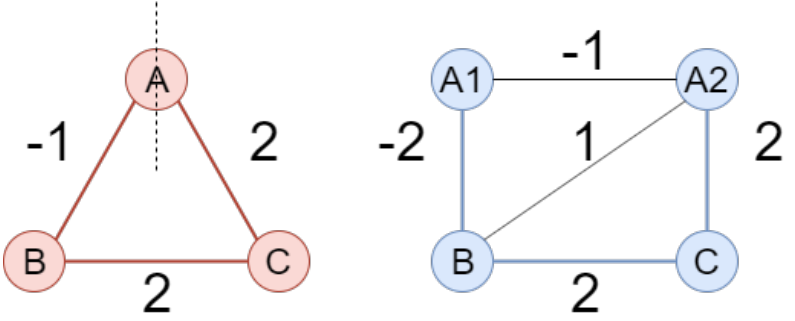
Figure 3. Rebalancing an unbalanced triangle by splitting one vertex.